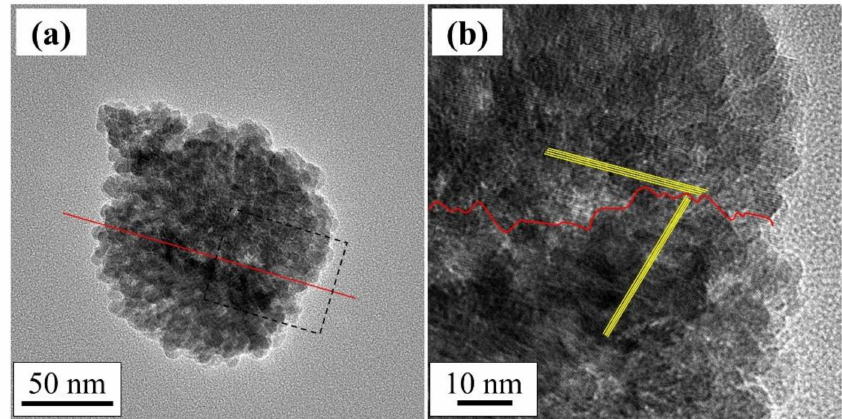
Figure 10. TEM images of ( a ) two raspberry-shaped particles bound via self-aggregation and sintering after CO oxidation testing from 25 to 350 ◦ C and ( b ) enlarged view of the place indicated by dot dashed square in Figure 10a. The boundary between the two particles were indicated by red line and the yellow lines indicates lattice fringes of two raspberry-shaped particles.